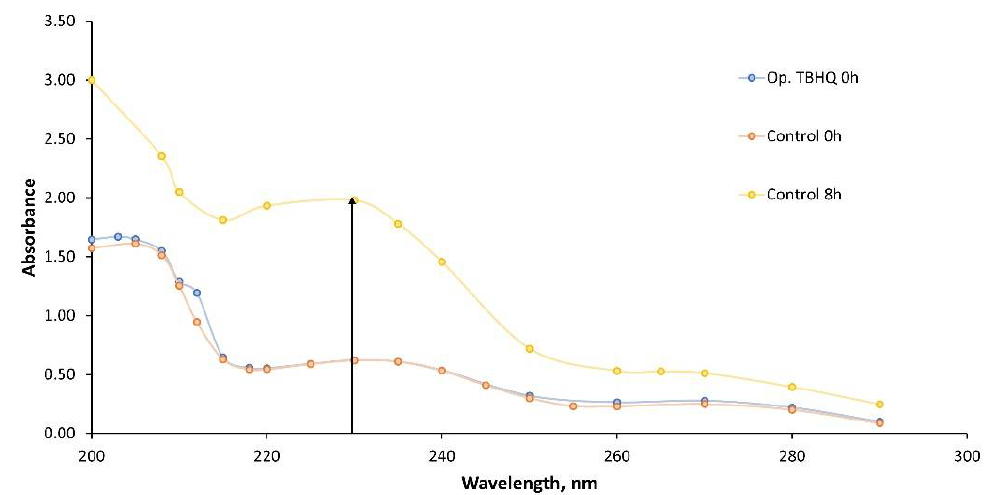
Figure 14. Wavelength selection to assess changes in UV during FOBL oxidation.